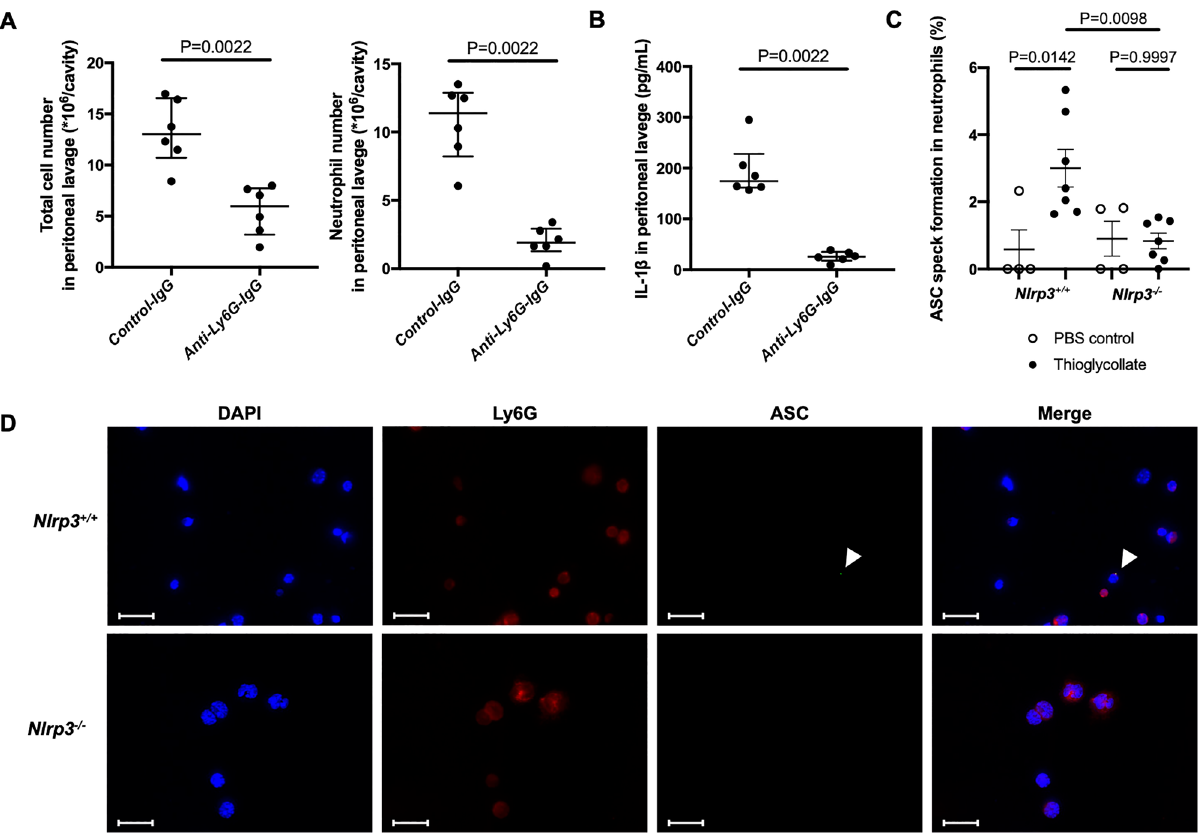
Figure 2. Neutrophils are required for IL-1β release and show signs of inflammasome activation (speck). ( A , B ) Thioglycollate-induced peritonitis model in wild-type mice pretreated with anti-Ly6G antibody or control antibody (n = 6:6), evaluation of lavage cells and fluid. ( A ) Total cell number, absolute numbers of neutrophils, and ( B ) IL-1β concentration in peritoneal lavage fluid. ( C , D ) Nlrp3 + / + and Nlrp3 −/− mice were i.p. injected with 1 mL sterile 3% thioglycollate broth (closed circles) or 1 mL sterile PBS (open circles). ASC speck formation in intraperitoneal cells was examined one hour afterward. ( C ) Quantification of neutrophils presenting ASC speck in a separate experiment (PBS control, n = 4:4; Thioglycollate, n = 7:7). ( D ) Representative microscopy images of immunostained cells in the intraperitoneal lavage fluid captured at 100x. Blue, DNA (DAPI); red, Ly-6G; green, ASC antibody staining. White arrows indicate ASC speck. Scale bar equals 20